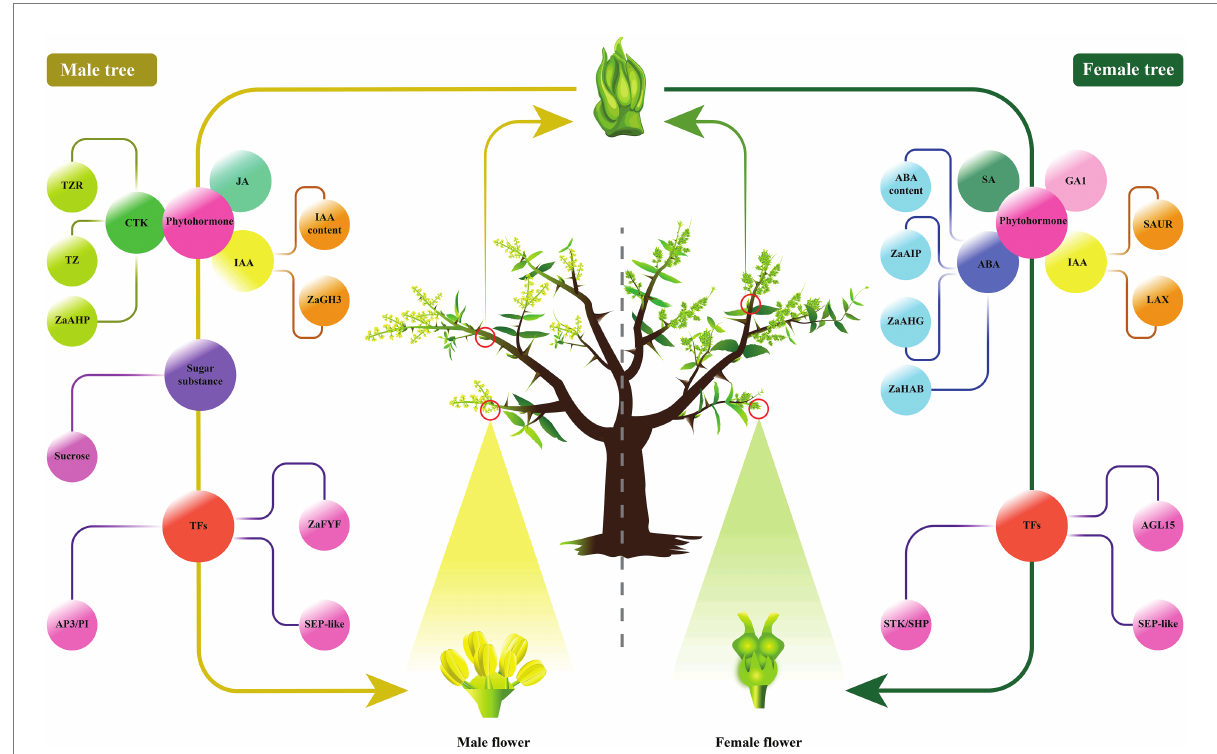
FIGURE 8 The schematic model illustrating the floral sex regulatory in Z. armatum . The male floral differentiation might be triggered by plant growth compounds and genes involved in phytohormone, sugar substance, and TFs, such as CTK, JA, IAA, sucrose, AP3/PI, ZaFYF, SEP-like. While, the female floral differentiation might be initiated by SA, GA1, ABA and IAA biosynthesis and signal transduction, as well as the transcription factors of STK/SHP, AGL15,